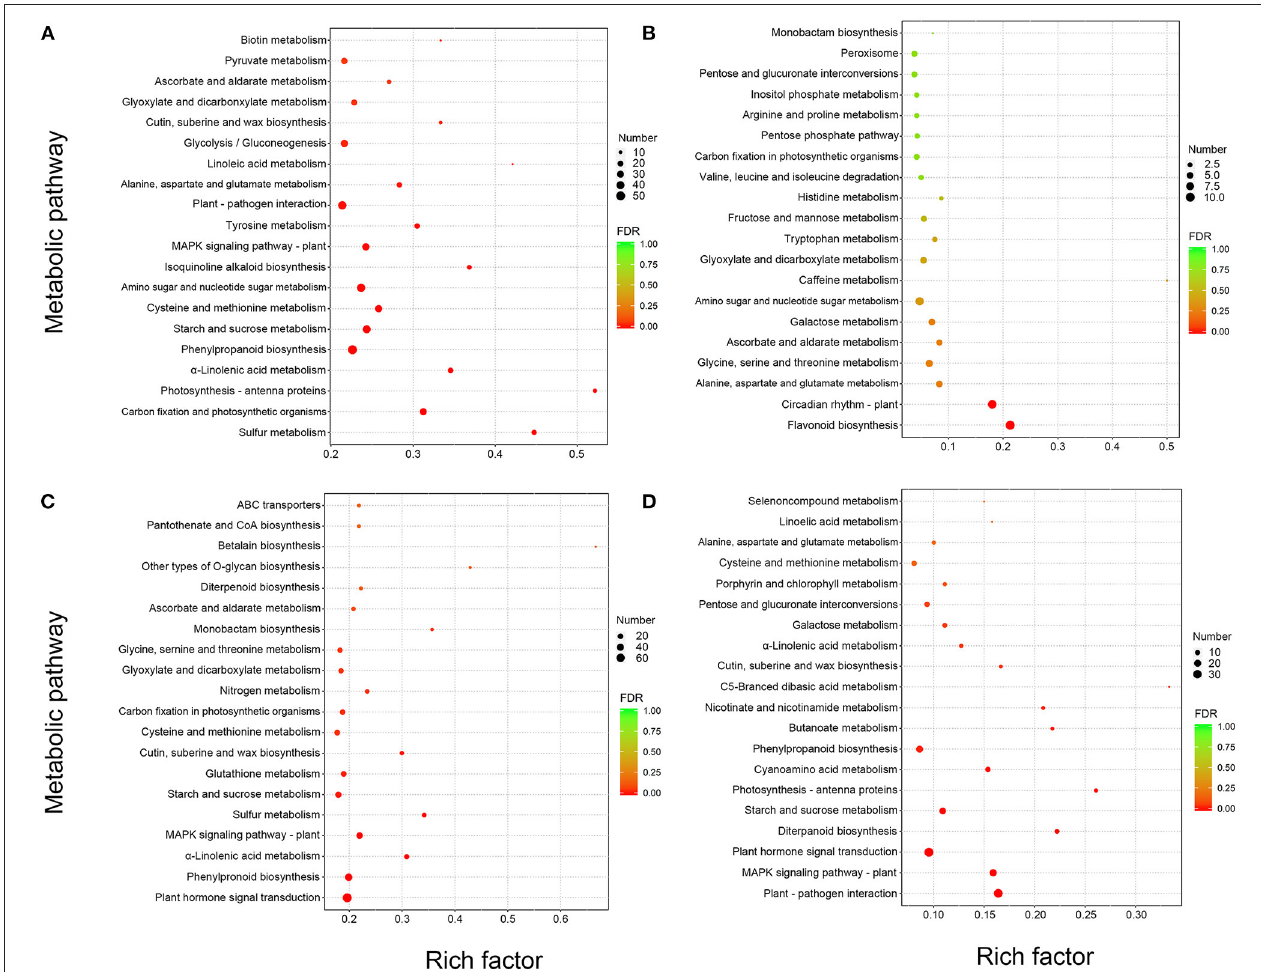
FIGURE 2 | Enrichment analysis of all DEGs. The top 20 Kyoto Encyclopedia of Genes and Genomes (KEGG) pathways with the most significant enrichment of (A) Mk_24h/Mk_6h, (B) Mb_6h/Mk_6h, (C) Mb_24h/Mk_24h, and (D) Mb_24h/Mb_6h, accordingly. The “/” implies “vs.” The diameter of the cycle is positively correlated with the number of DEGs, and the color of the cycle indicates the false discovery rate (FDR) value as the scale